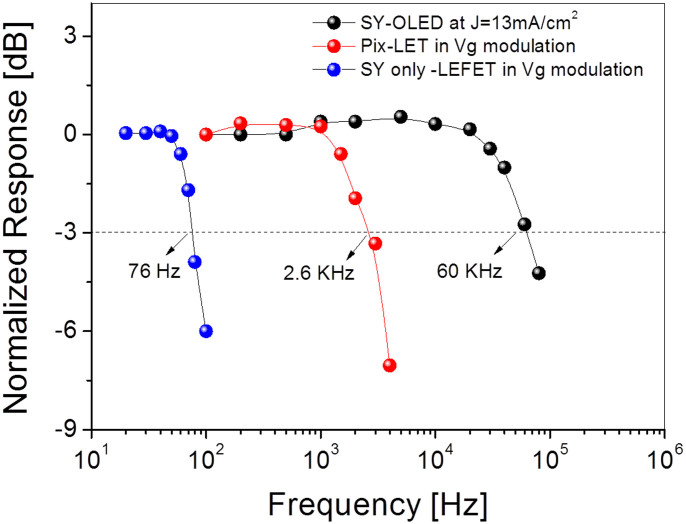
Bode plot for a SY OLED, a 100 μm channel Pix-LET, and a single layer SY-only LEFET21 in gate modulation mode.